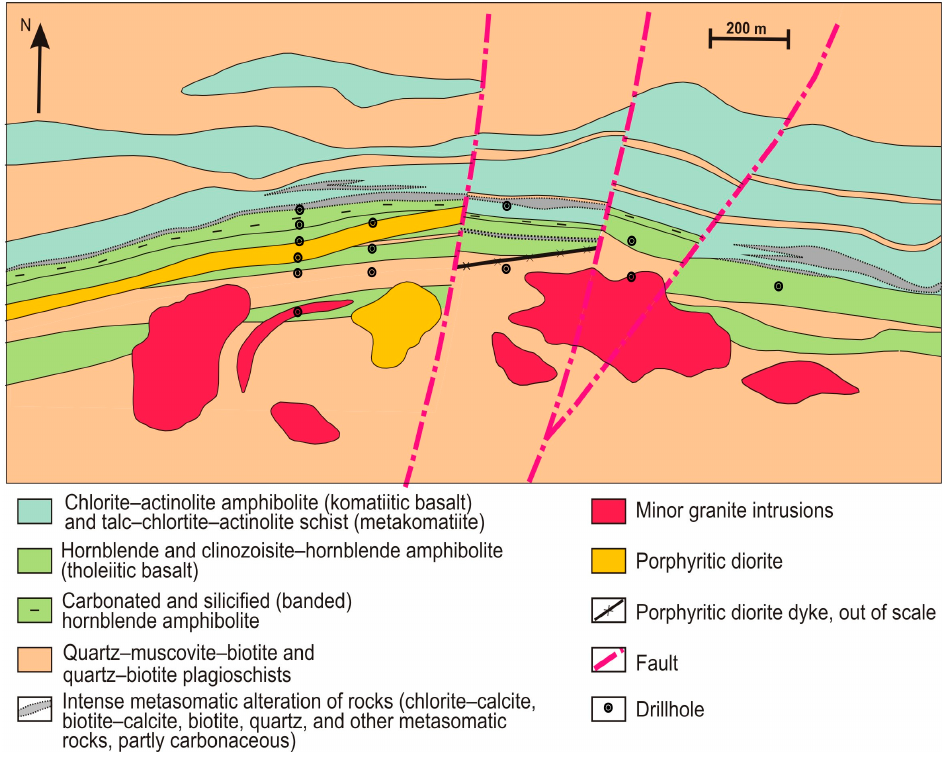
Table 6. General characteristics of the gold deposits in the Strel’na greenstone belt.